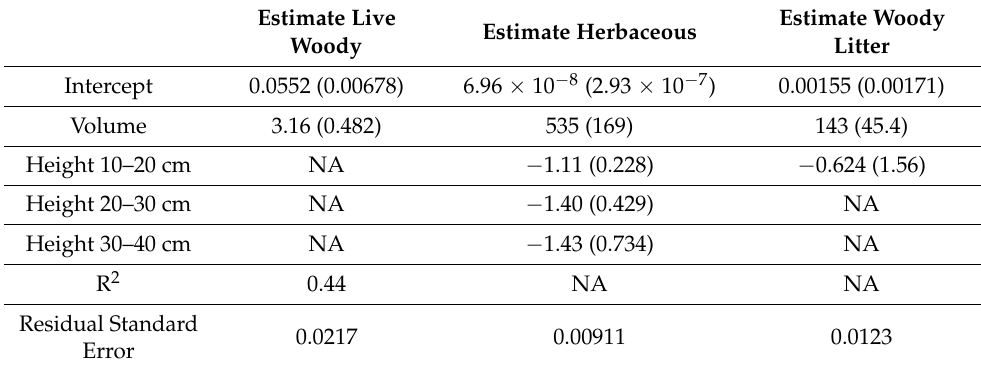
Table 3. Fuel consumption (g) in four plots for each fuel category. Before treatment application, pre-fire and post-fire plots were paired based on dominant fuel type. Fuel consumption in paired plots was calculated by subtracting biomass in post-fire plots from biomass in pre-fire plots within fuel categories. The regression equation for each fuel type was used to estimate biomass present in